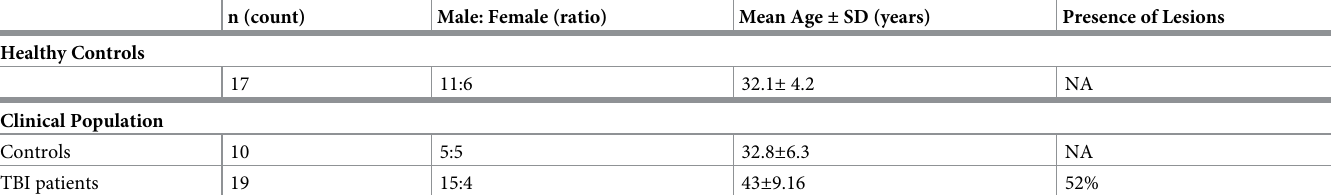
Table 1. Cohort demographics. Demographics of patients and healthy controls used in the validation and testing of the SDSS